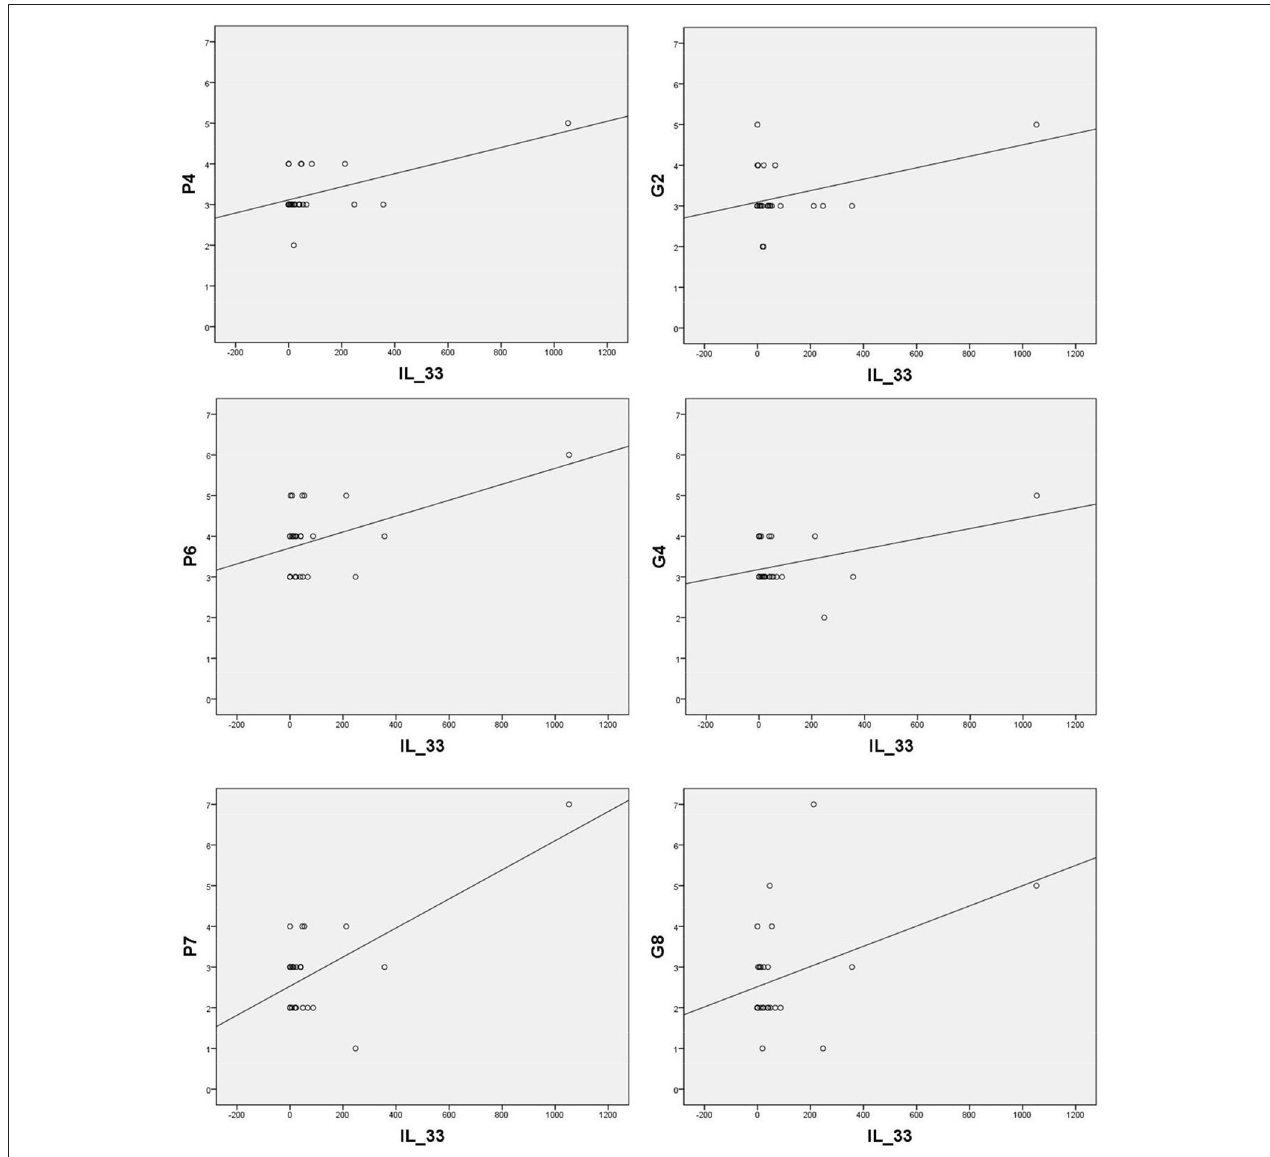
FIGURE 2 | Significant correlation of IL-33 with positive PANSS items [P4 ( r = 0.570; p = 0.002), P6 ( r = 0.486; p = 0.010), P7 ( r = 0.664; p = 0.000)] and general PANSS symptoms [G2 ( r = 0.424; p = 0.028), G4 ( r = 0.435; p = 0.023) and G8 ( r = 0.396; p =